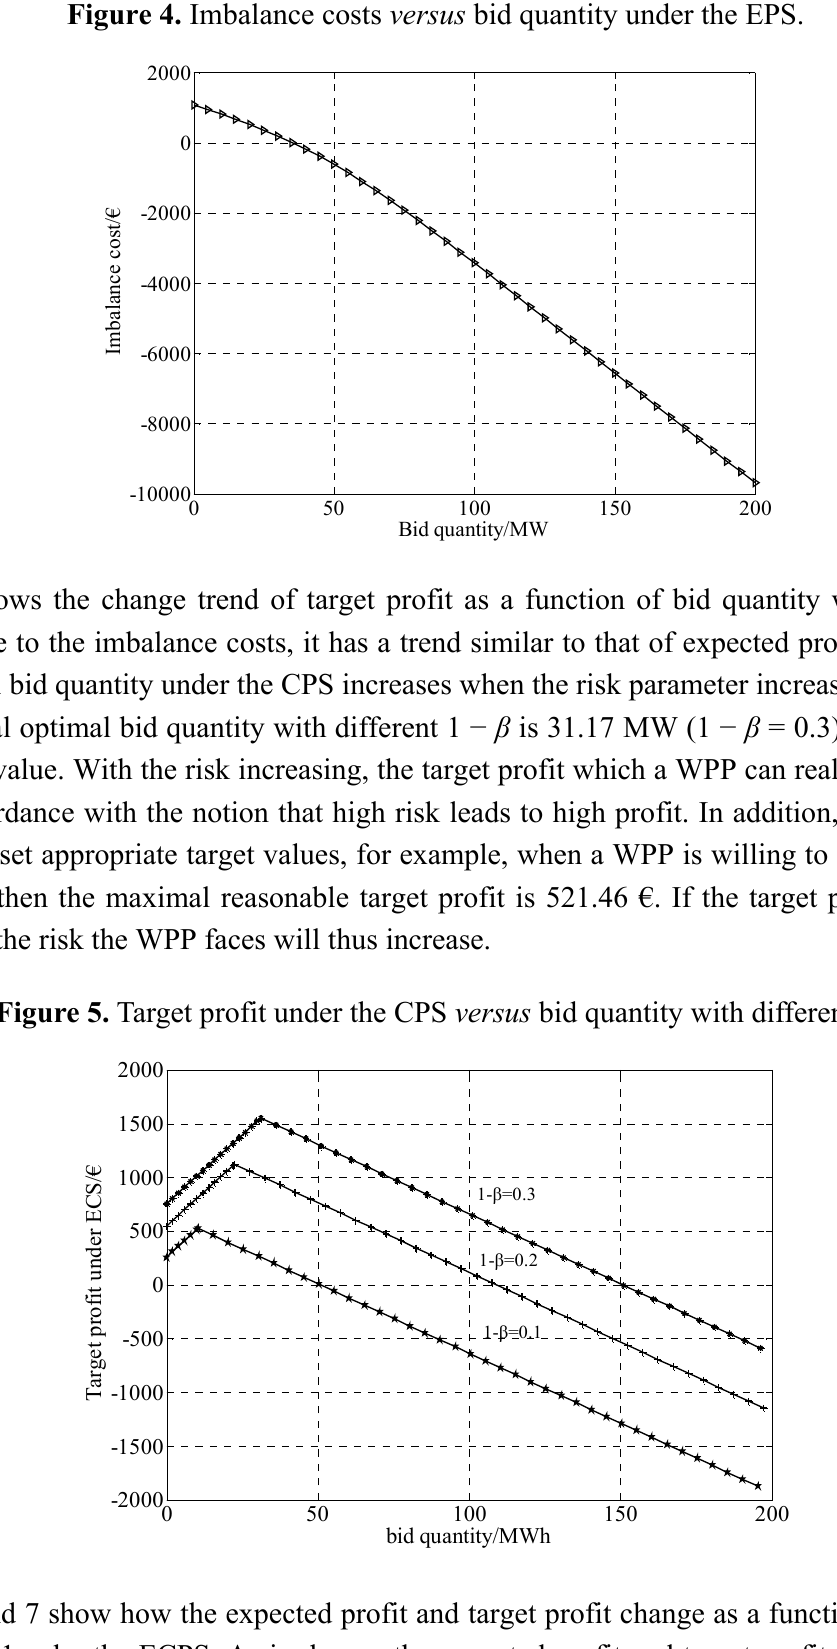
Figure 4. Imbalance costs versus bid quantity under the EPS.